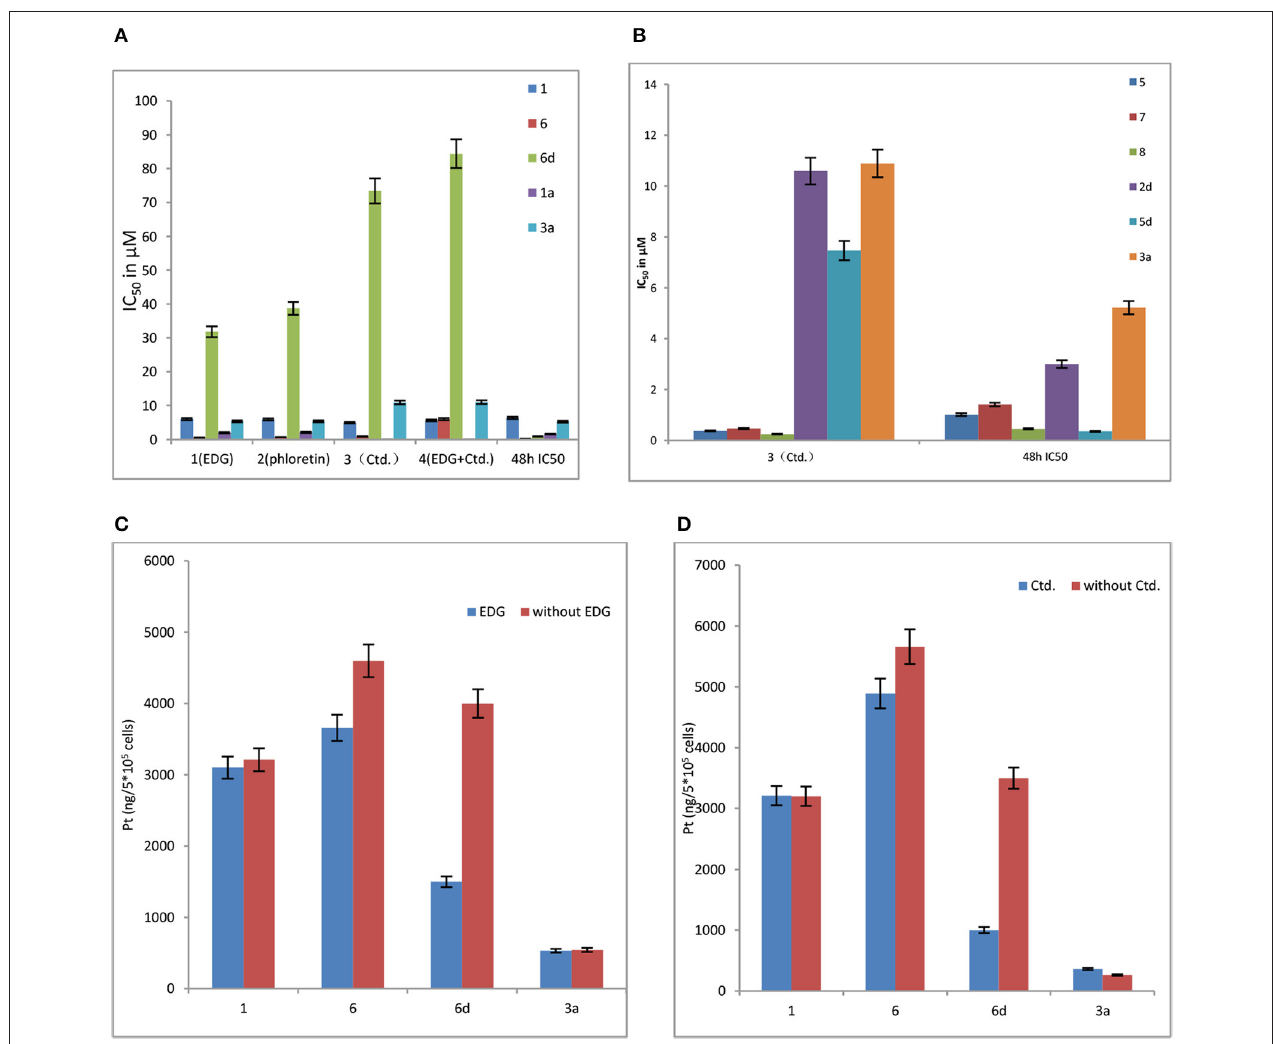
FIGURE 3 | (A) Effects of EDG (1), phloretin (2), Ctd. (3), and a mixture of EDG and Ctd. (4) on the IC 50 values of compounds 1, 6, 6d, 1a , and 3a in MCF-7 cells. (B) Effects of Ctd.(3) on the IC 50 values of on compounds 5, 7, 8, 2d, 5d , and 3a in MCF-7 cells. (C) Effects of EDG on the cellular uptake of compounds 1, 6, 6d , and 3a in MCF-7 cells. (D) Effects of Ctd. on the cellular uptake of compounds 1, 6, 6d , and 3a in MCF-7